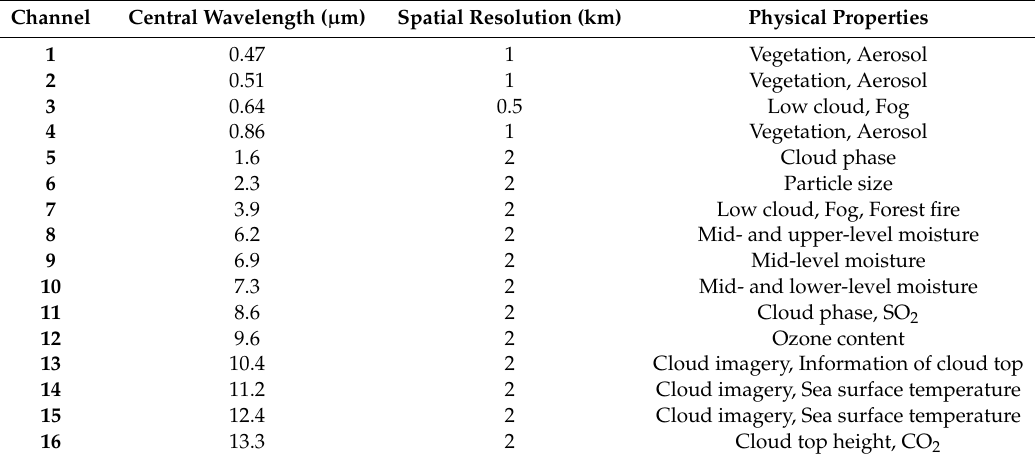
Table 1. Characteristics of the AHI channels.